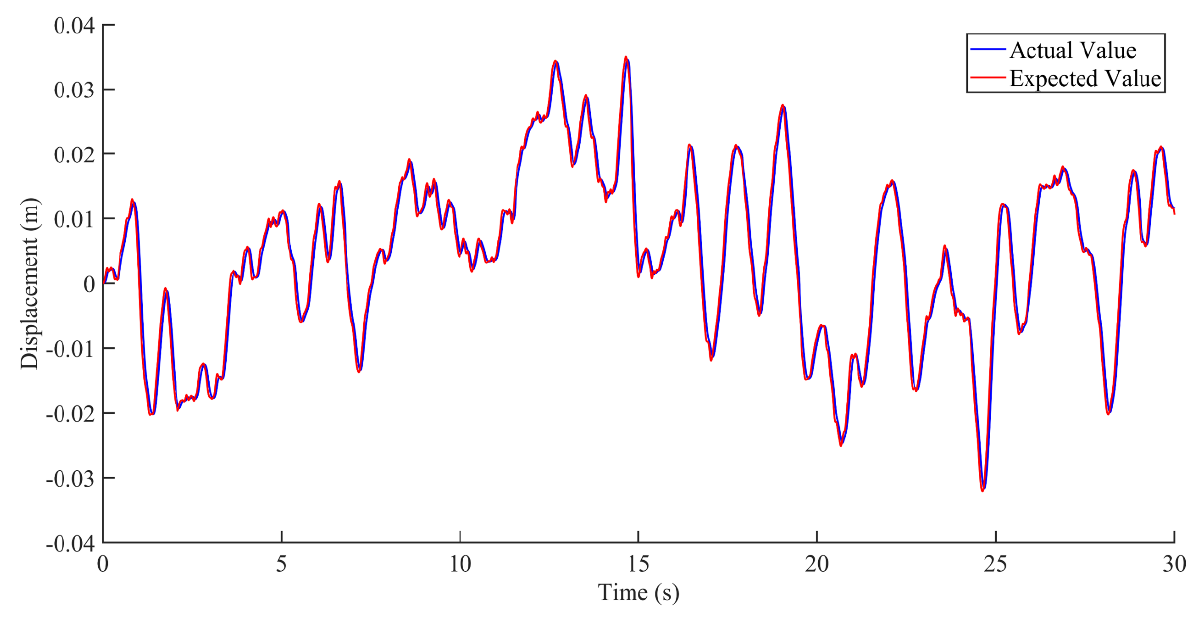
Figure 12. Comparison between actual value and expected value of vibration displacement based on state feedback control under the condition of no interference.